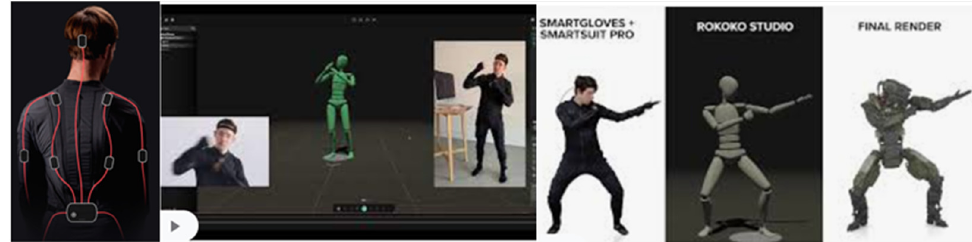
Figure 7. ( Left ) The sensors inside the suit textile. ( Middle ) The Rokoko studio. ( Right ) How an actor’s movements are translated into avatar movements in real time.